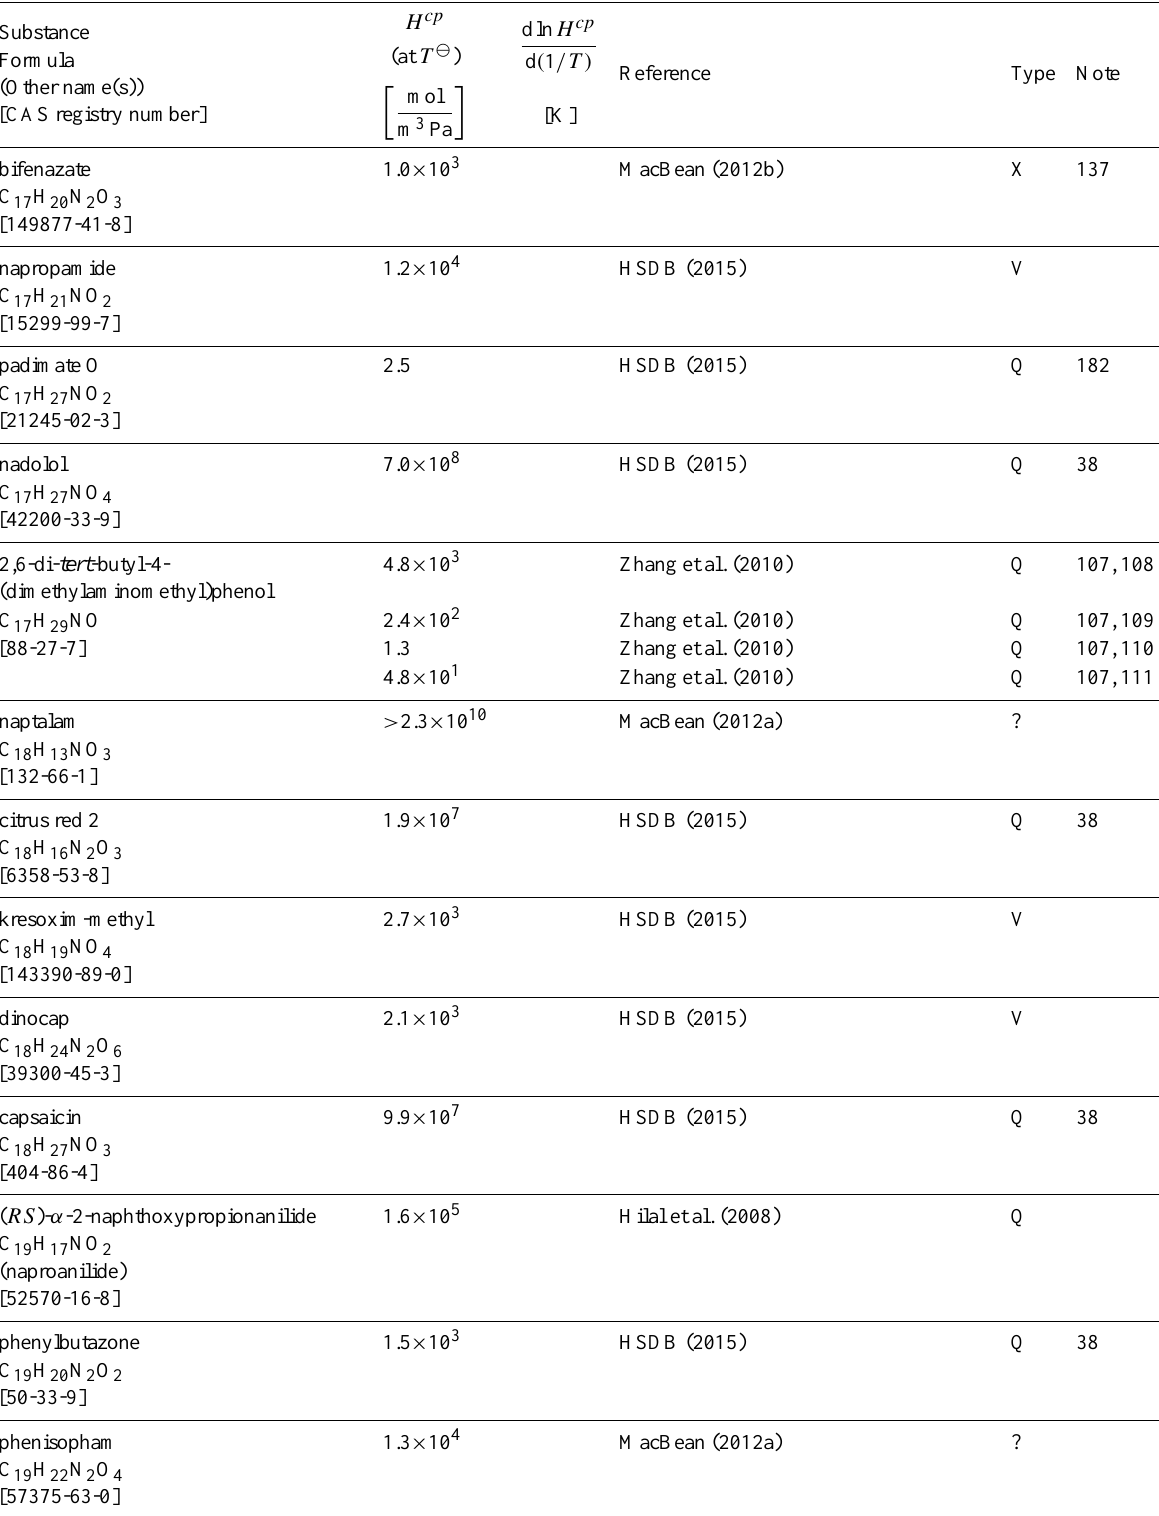
Table 6: Henry’s law constants for water as solvent